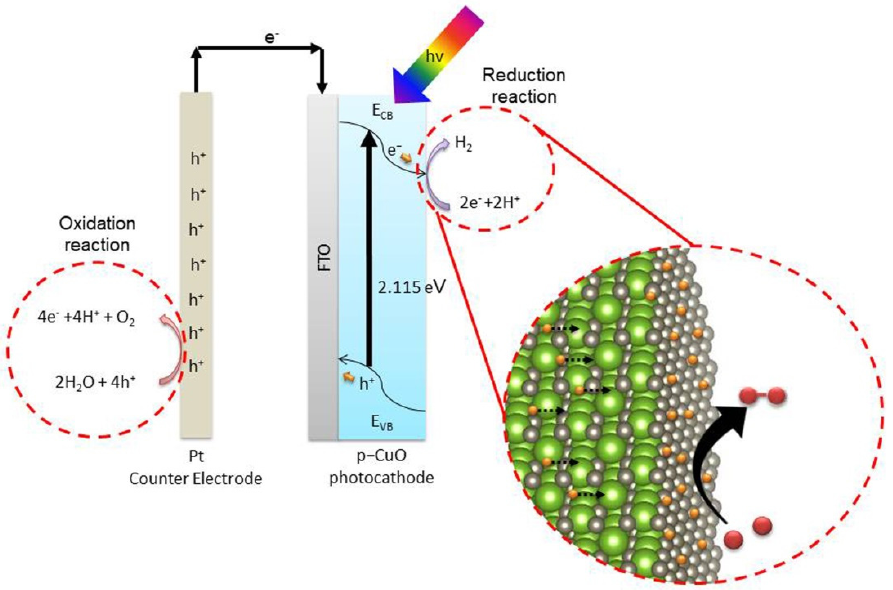
Figure 7. Schematic of the mechanism of the photochemical reaction of the CuO thin films. The green dots and gray dots are Cu and O, respectively, in the crystal structure of CuO; electrons (yellow dots) are formed inside the CuO photocathode when illuminated; then, they move to the surface of the electrode and interact with the red dots (H + ions) to form H 2 bubbles.